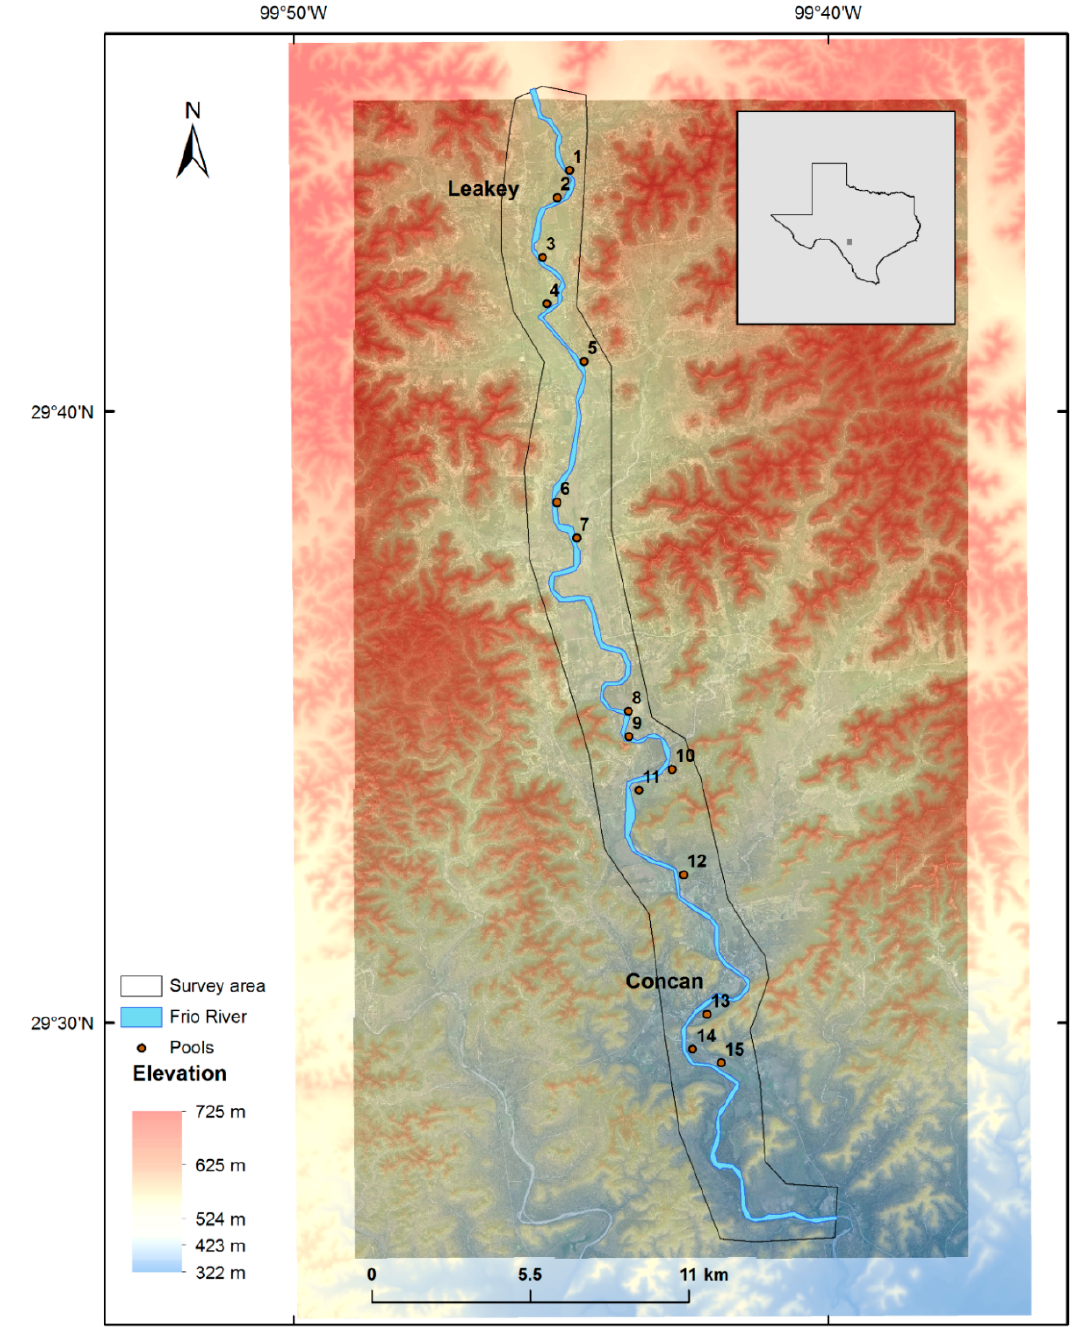
Figure 3. Frio River study area. Basins are in sequence from one to fifteen, north to south.